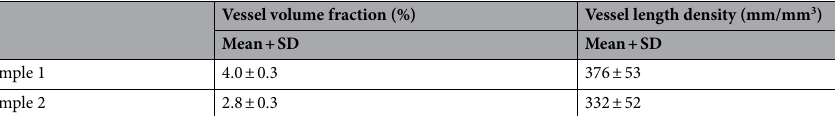
Table 1. Summary of vascular features from 0.94 µm voxel size phase-contrast microtomography. For each sample, the mean and standard deviation (SD) across regions-of-interest (cfr Fig. S4) are